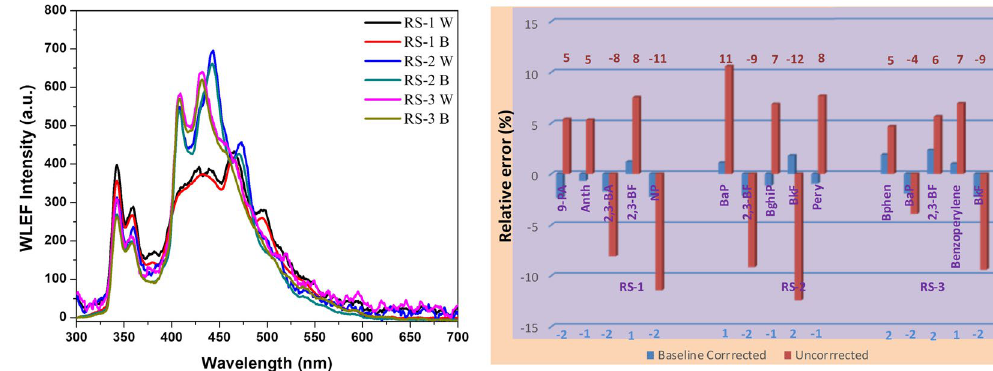
Figure 5. ( a ) WLEF spectra of 3 mixtures of PAHs spiked river samples (RS) without (W) and with baseline correction (B) measured in real time using SDS micellar media. ( b ) Relative prediction error in the percentage recovery of spiked mixtures in three RS. The red histogram (with % error) shows uncorrected spectral deconvolution using MCR-ALS and blue histograms for the respective baseline corrected [spectral measurements are triplicated and deviation from the mean is less than 2%].